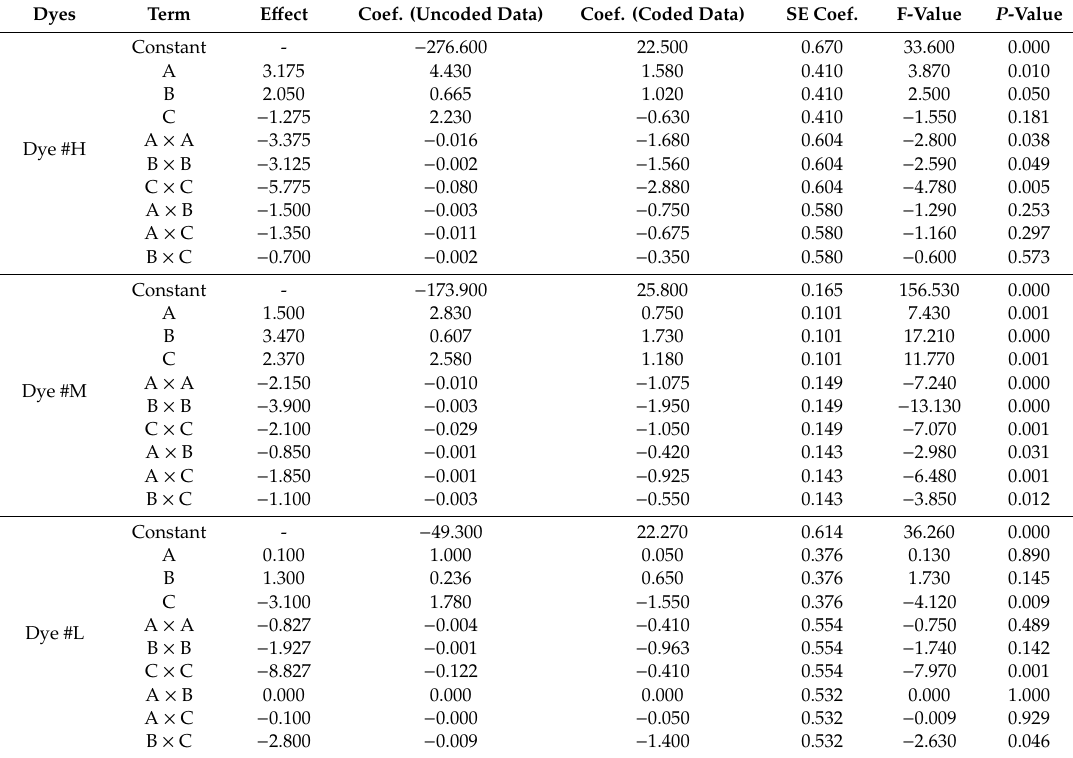
Table 5. ANOVA table of the color yield (K / S) for the studied parameters (R 2 (adj) = 92.32%, 99.83% and 94.83% for Dye #H, Dye #M, and Dye #L,